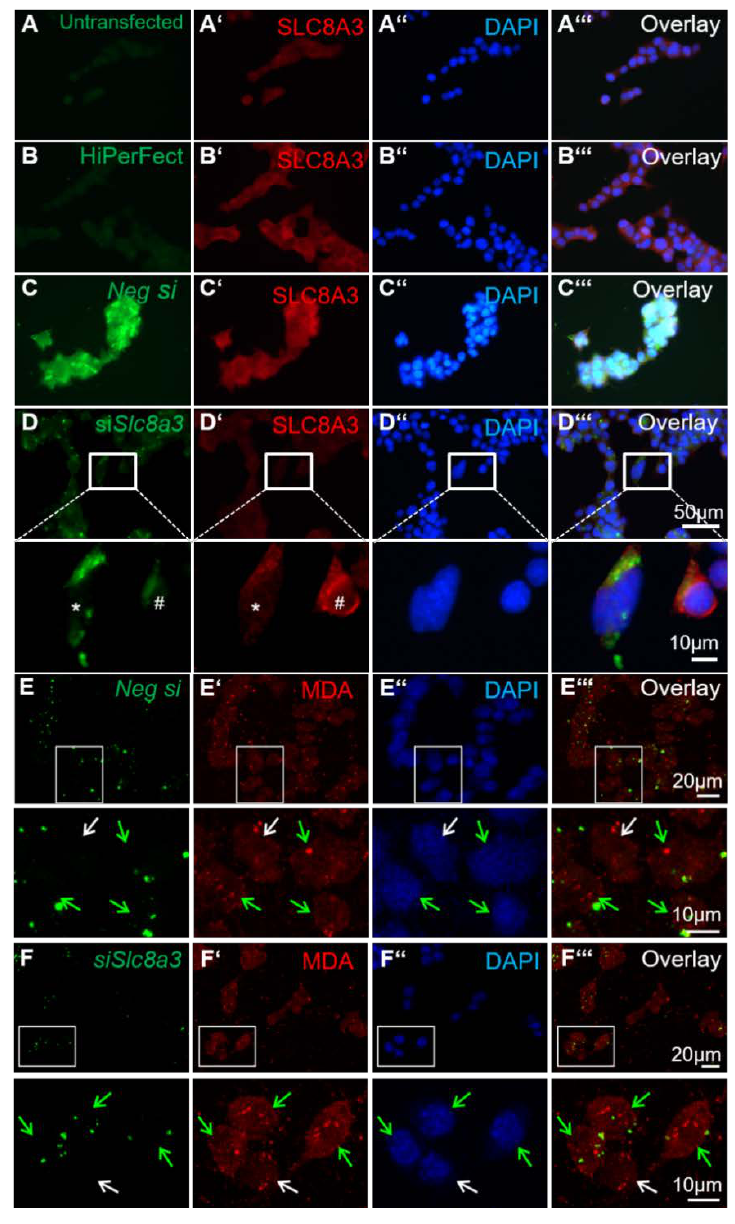
Figure 6. Knockdown of Slc8a3 increases oxidative stress. ( A – D ) Efficiency of SLC8A3 knockdown. SLC8A3 immunofluorescence in MN9D cells that were either non-transfected (A, untransfected), treated with the transfection agent only (B, HiPerFect), transfected with negative siRNA (C, green, Neg si ), or with a specific siRNA against Slc8a3 (green in D). SLC8A3 protein showed no differences between the controls and the cells transfected with negative siRNA but was significantly downregulated in cells transfected with specific Slc8a3 siRNA (magnification of the white boxed areas). ( E – E’’’ ) Immunofluorescence for the lipid peroxidation marker malondialdehyde (MDA) was comparable between MN9D cells transfected with negative si RNA (green arrows) and non-transfected cells (white arrow). ( F – F’’’ ) MDA immunofluorescence was increased in cells transfected with specific siRNA against Slc8a3 . Green arrows indicate successfully transfected cells with specific siRNA against Slc8a3, white arrow points to a cell from the same culture that failed to incorporate Slc8a3 siRNA.